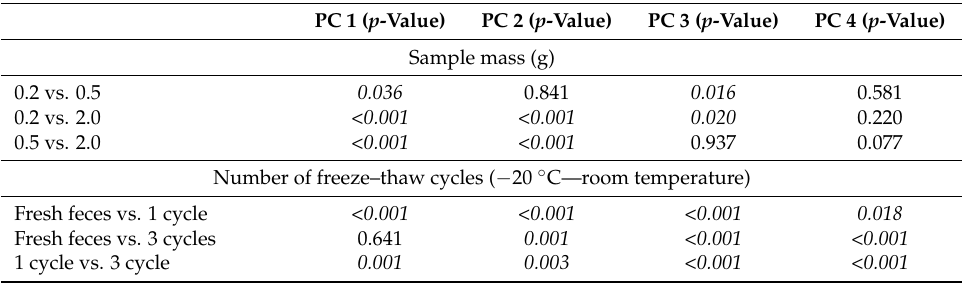
Table 1. Principle component analysis per variable of interest with corresponding p -values.